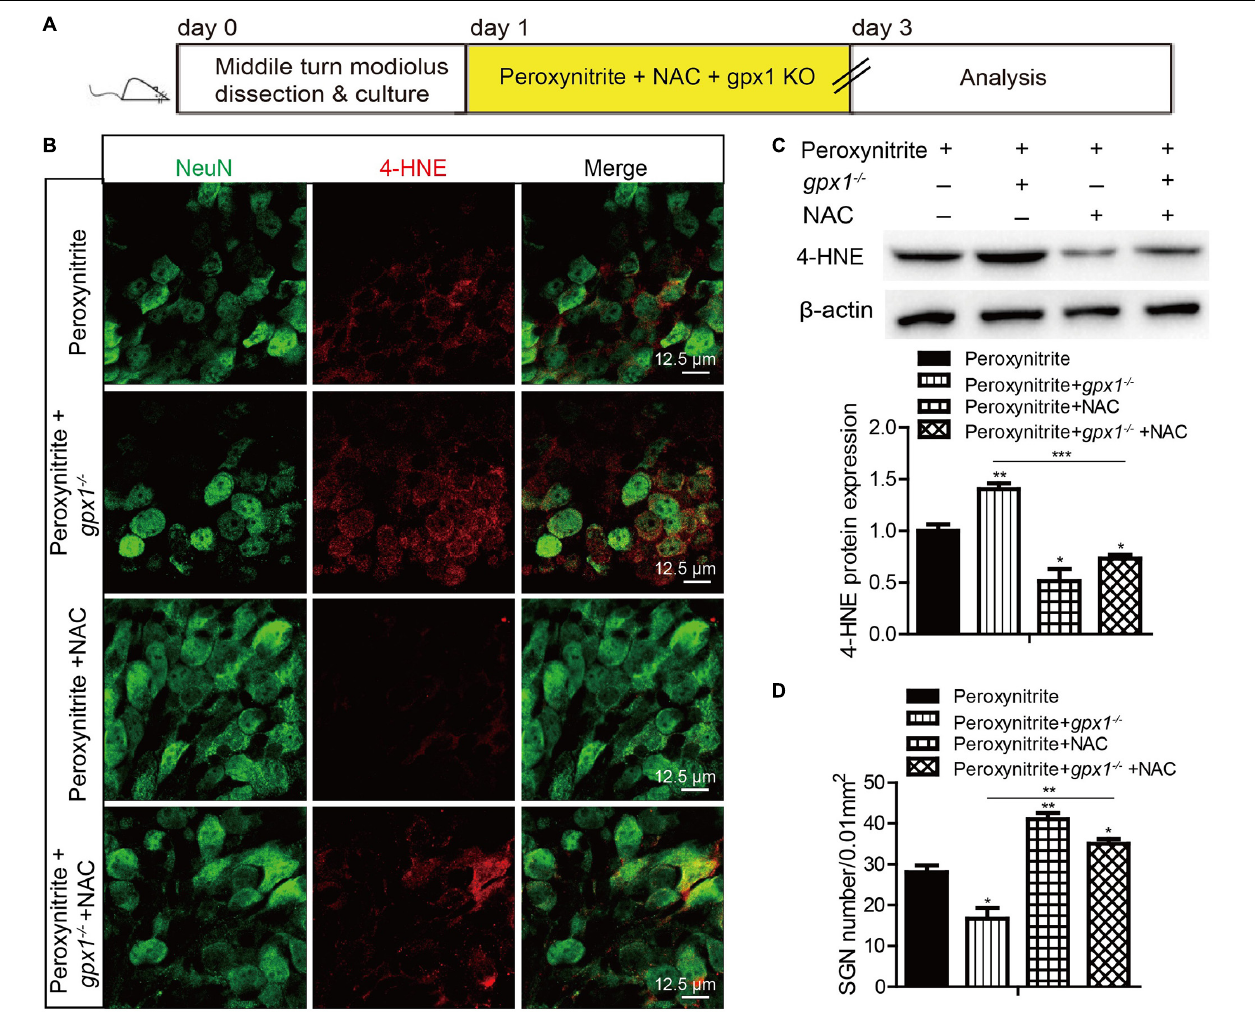
FIGURE 6 | Antioxidant treatment rescues the aggravated SGNs loss and ROS accumulation induced by GPX1 deficiency after peroxynitrite injury. (A) The cultured SGNs from WT or gpx1 − / − mice were treated with peroxynitrite and 2 mM NAC for 48 h. (B,C) Immunostaining results illustrated that the immunofluorescence of 4-HNE was weaker in the peroxynitrite + NAC group compared with the peroxynitrite-only group, and it was also lower in the peroxynitrite + gpx1 − / − + NAC group compared with the peroxynitrite + gpx1 − / − group. Western blot results verified that the protein expression level of 4-HNE was consistent with the immunostaining results. Scale bar = 12.5 µ m. (D) Cell counting and statistical analysis showed that the NAC treatment largely increased the number of surviving SGNs in the peroxynitrite + N-acetylcysteine (NAC) group compared with the peroxynitrite-only group, as well as in the peroxynitrite + gpx1 − / − + NAC group compared with the peroxynitrite + gpx1 − / − group. * p < 0.05, ** p < 0.01, and *** p < 0.001, n = 3 for each